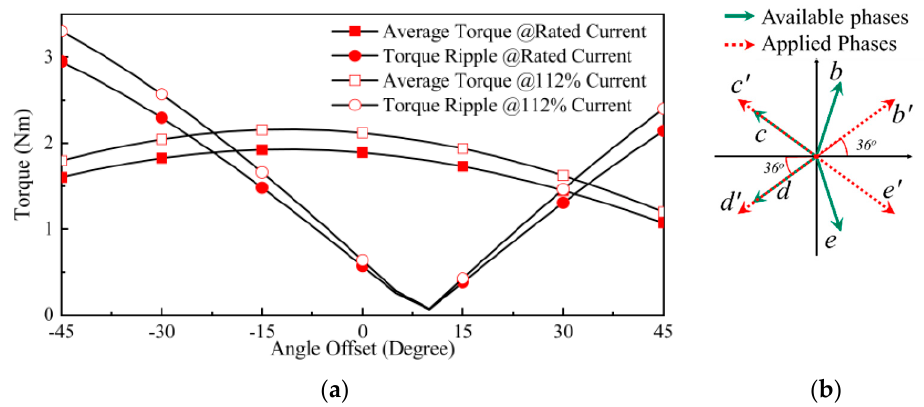
Figure 7. ( a ) Torque with respect to the offset angle for a one-phase fault; ( b ) proposed solution for a one-phase